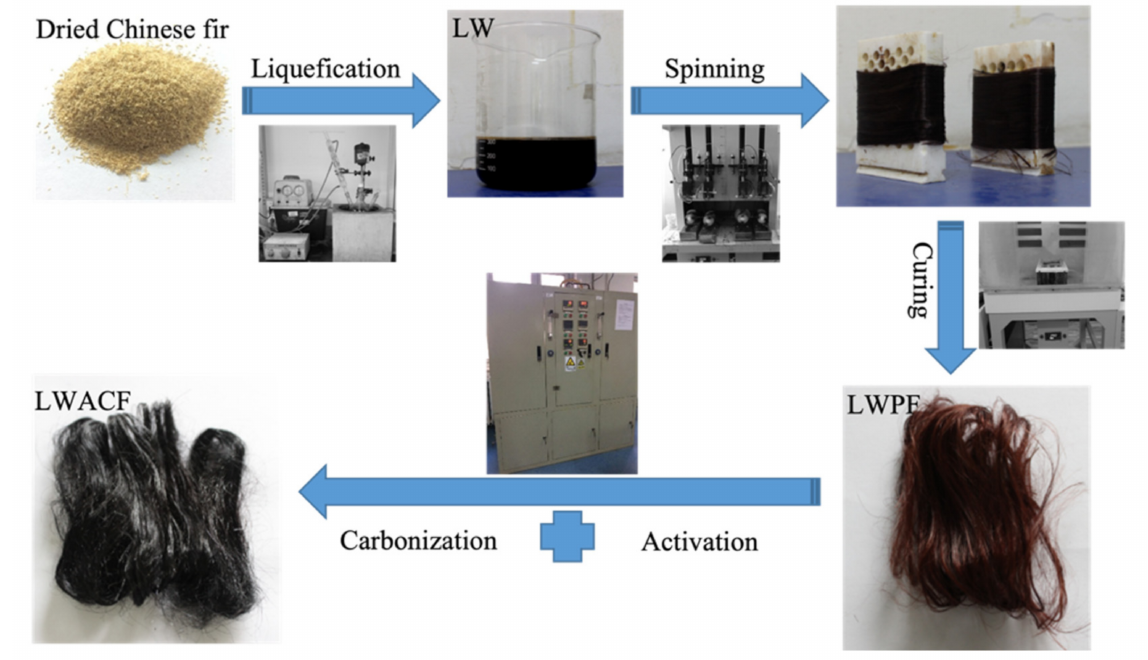
Figure 1. Synthesizing route of the series of